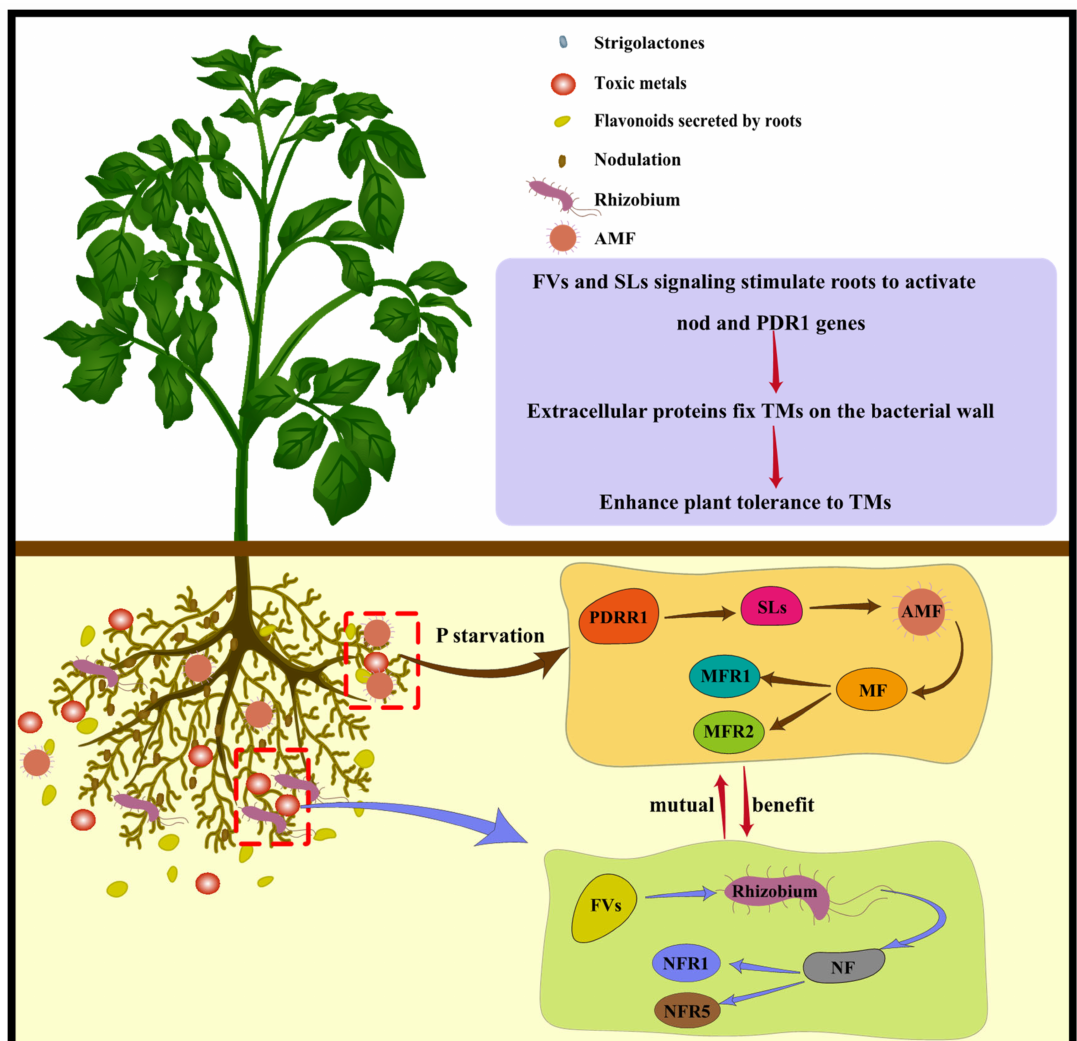
Figure 8. Simplified diagram of flavonoids and solanum lactones bound to TMs secreted by host roots. MF: Myc factors (MFR1 and MFR2). NF: Nod factors (NFR1 and